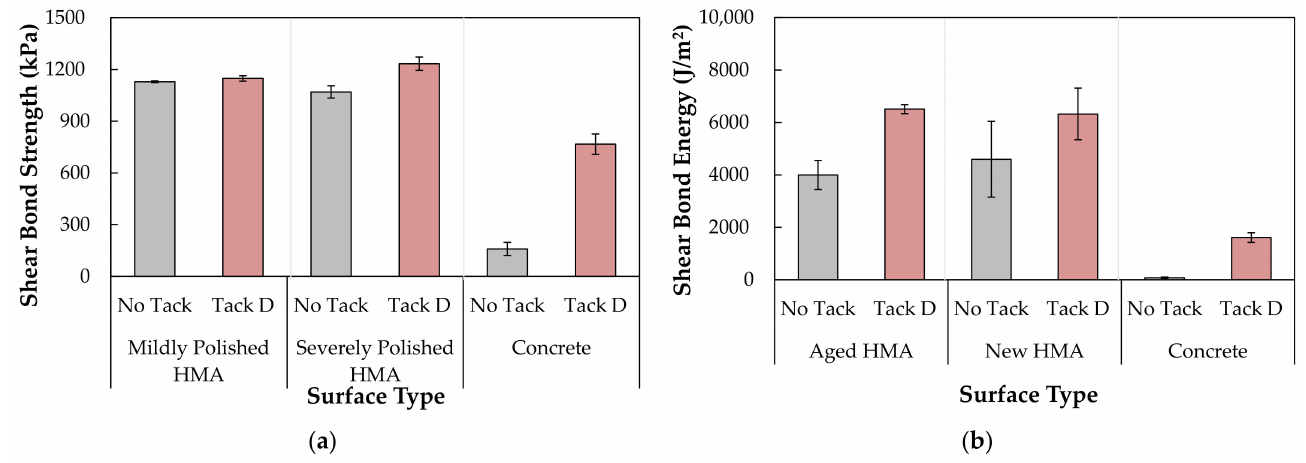
Figure 7. Effect of substrate type on ( a ) shear strength and ( b ) shear bond